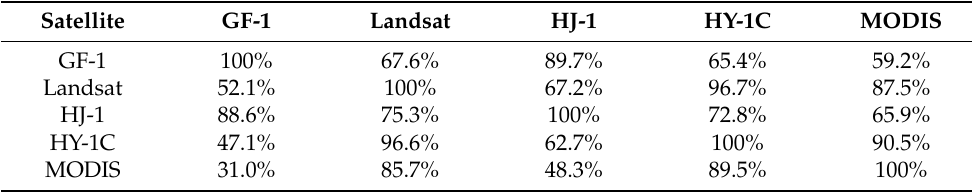
Table 7. Area consistency coefficient of green tide extraction